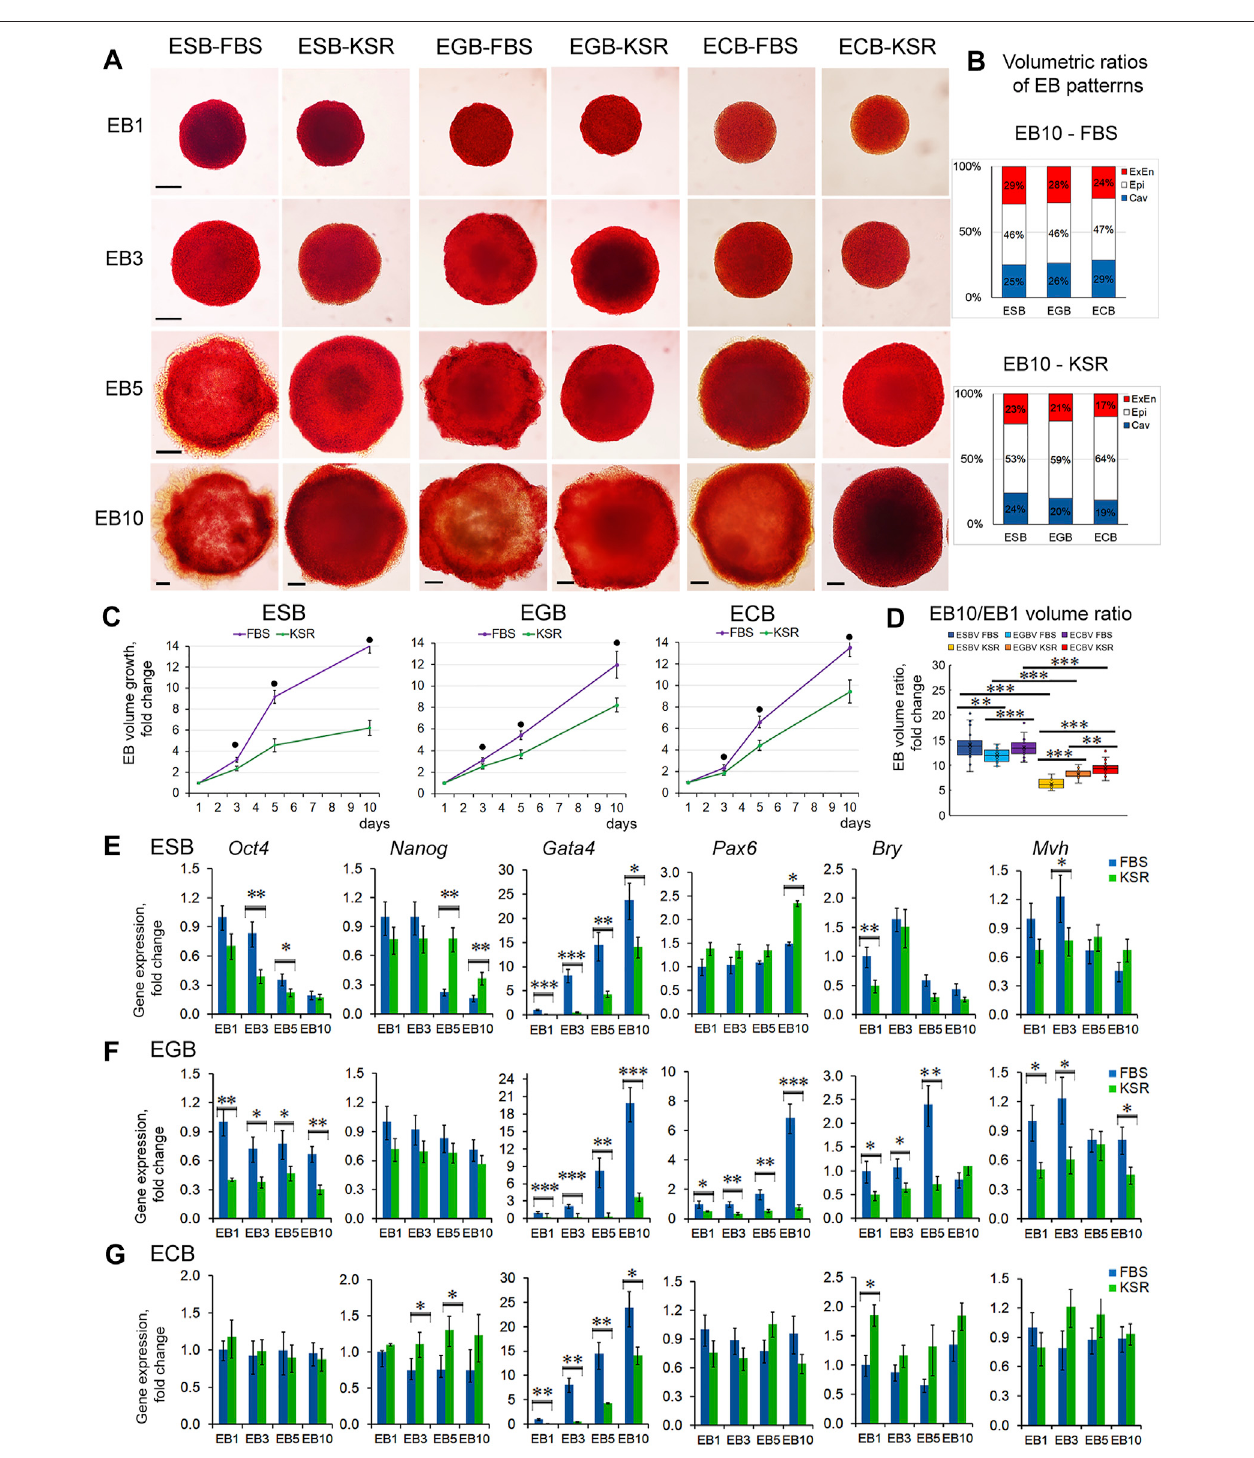
FIGURE6| EBgrowth,differentiation,andpatterningindifferentcultureconditions. (A) MorphologicalanalysisandALP-stainingofdifferentiatingESBs,EGBs,and ECBs grown in KSR- and FBS-media. (B) The stacked barplots indicate the percentages of volumetric ratios of ExEn, Epi-l, and cavity patterns in ESBs, EGBs, and ECBs atday10intheKSR-andFBS-media(24EBs/pergroup;threeexperiments; N=144foreachcellline). (C) DifferentEBgrowthdynamicsinKSR-andFBS-media for all cell lines (24 EBs/per stage for each group; three experiments; N = 576 for each cell line). The data are shown as averaged means ± s.d. from three